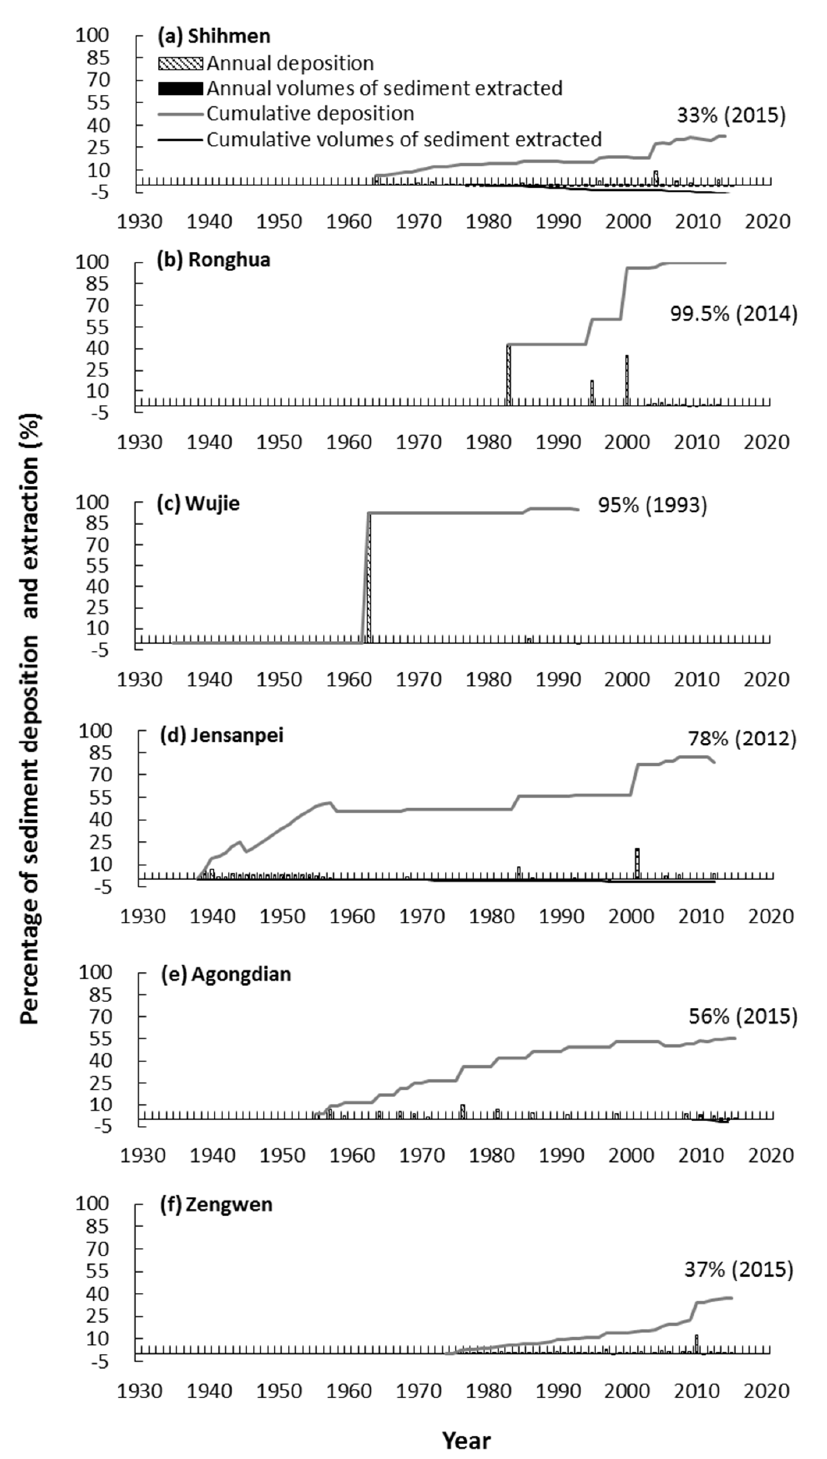
Figure 2. Reservoir sedimentation and removal over time. The percent capacity lost is reported along with the year of last reservoir survey at the end of each plot (data courtesy of WRA, Taipower Company, and Taiwan Sugar Corporation); ( a ) Shihmen Reservoir; ( b ) Ronghua Reservoir; ( c ) Wujie Reservoir; ( d ) Jensanpei Reservoir; ( f ) Zengwen Reservoir.